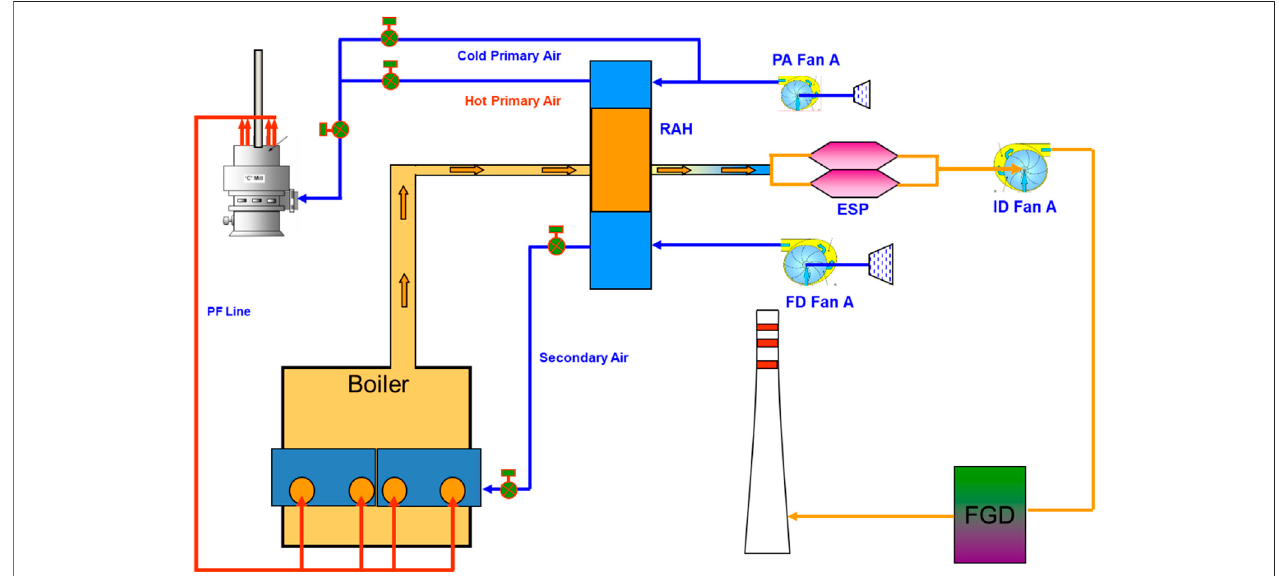
FIGURE 1 | Process Flow Diagram (PFD) of the reference plant: Primary air is supplied to the pulverizer through Primary Air Fan A (PA Fan A). The combined pulverized coal and air isfed tothe boiler throughPrimary Fan Line (PFLine) before itis mixed with the additional air supplied tothe boiler from Force Draft Fan A (FDFan A). The hot fl ue gas generated from the boiler is used to preheat the air feed of the boiler using the Rotary Air Heater (RAH). Dust in the fl ue gas is removed in an Electrostatic Precipitator (ESP) before it passes through the installed Induced Fan A (ID Fan A) to maintain a negative pressure in the boiler. The fl ue gas is then processed in the Flue Gas Desulphurization (FGD) to reduce the sulfur content in the fl ue gas before the gas is removed through the stack.